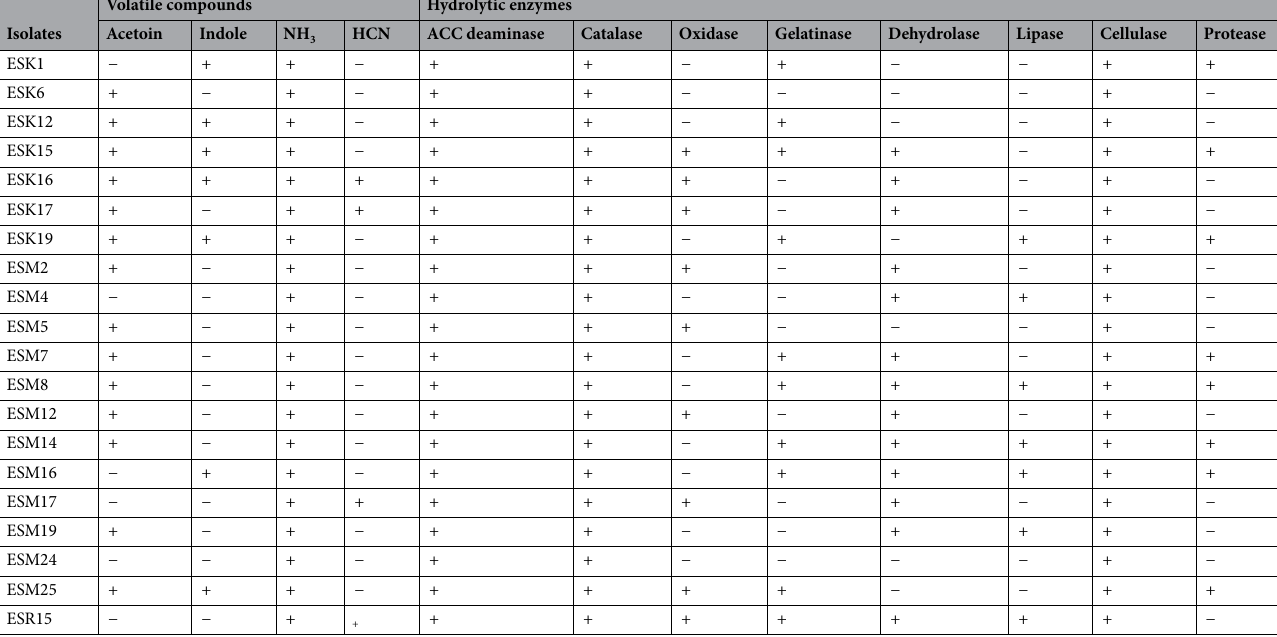
Table 3. Qualitative production of volatile compounds and hydrolytic enzymes by various halotolerant biofilm-producing rhizobacterial isolates. + = Positive for the respective test, − = Negative for the respective test. Pseudomonas chlororaphis ESR15 was used as